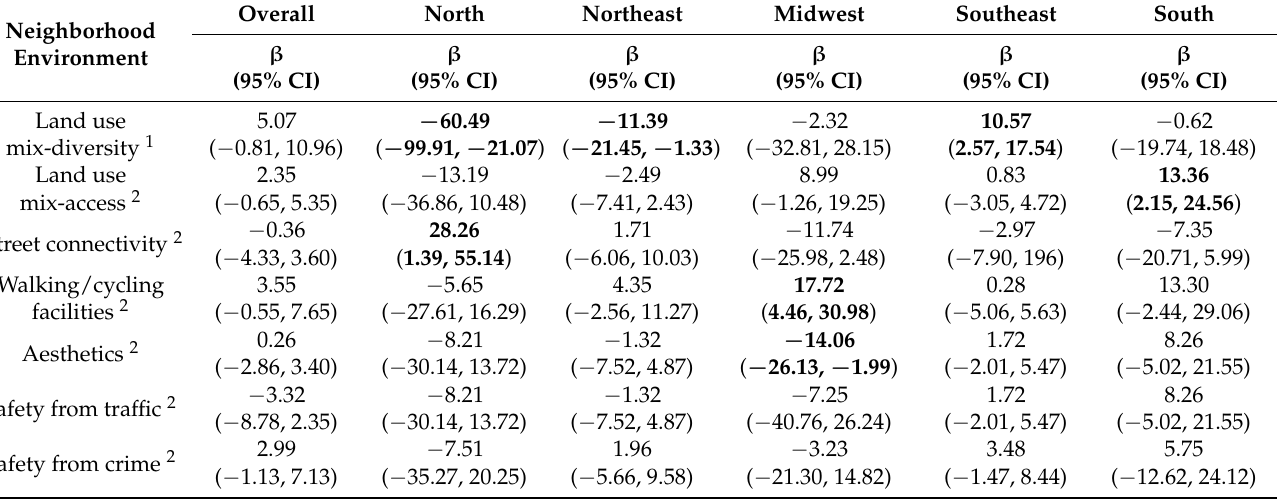
Table 5. Association ( β [95% CI]) between perceived neighborhood-built environment and sitting time